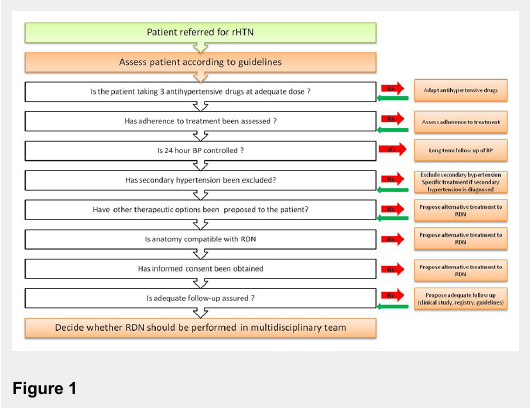
Suggested algorithm for the work-up before endovascular renal denervation (RDN) in resistant hypertension